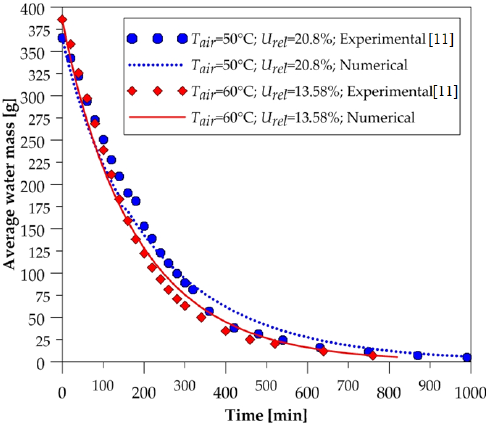
Figure 4. Average water mass of the brick as a function of the drying time (50 and 60 ◦ C).